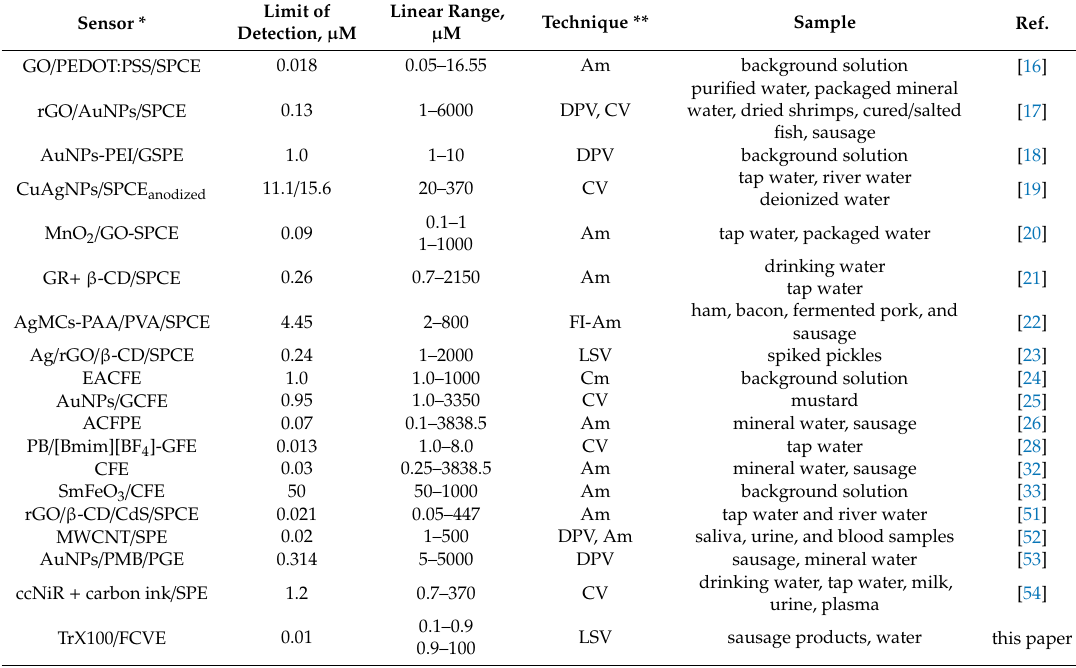
Table 2. Analytical characteristics of nitrite determination in real samples for di ff erent